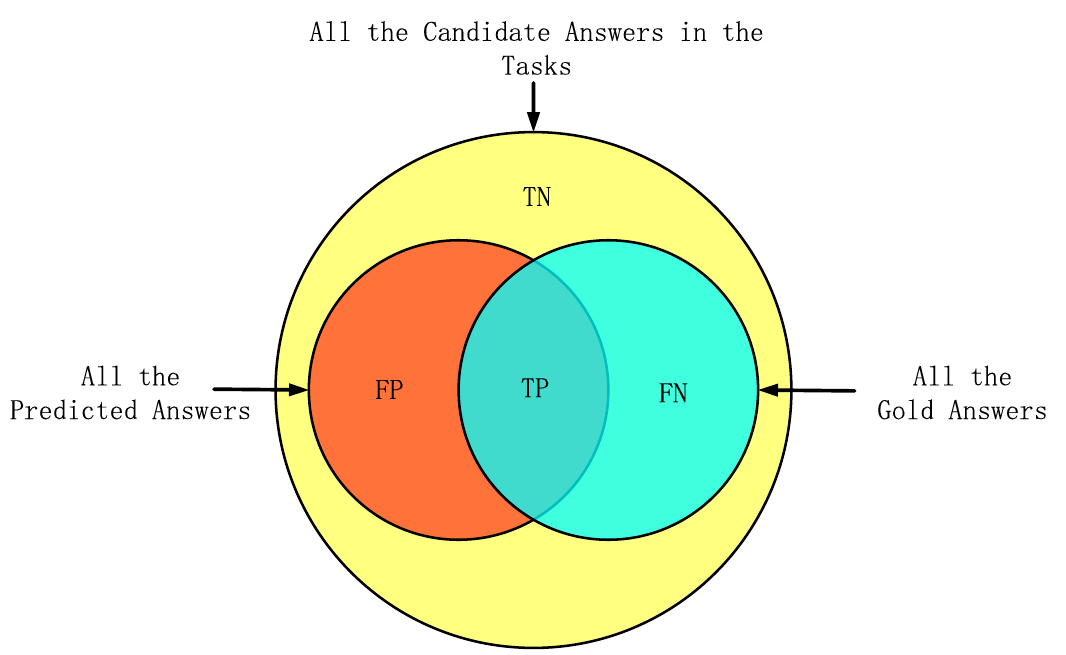
Figure 19. The question-level true positive (TP), false positive (FP), true negative (TN), and false negative